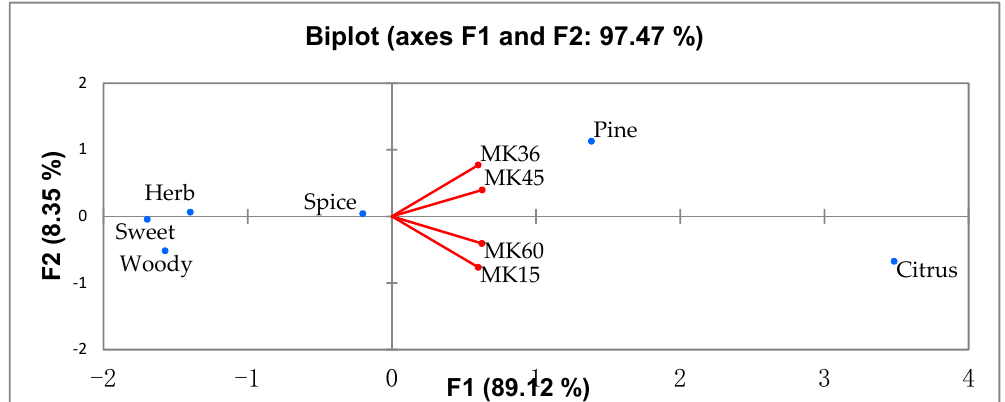
Figure 4. Principal component analysis (PCA) biplot (axes F1 and F2: 97.47%) illustrating the relationships among the odour attributes and different harvesting day of makhwaen fruit essential oil.